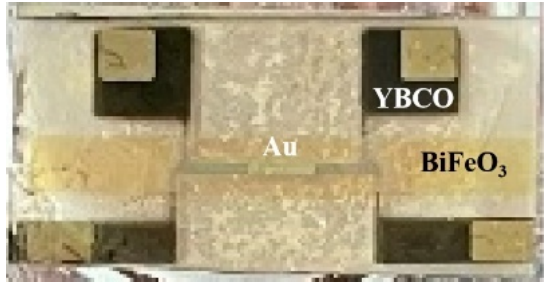
Figure 1. Image of the real Au/BFO/YBCO heterostructure.